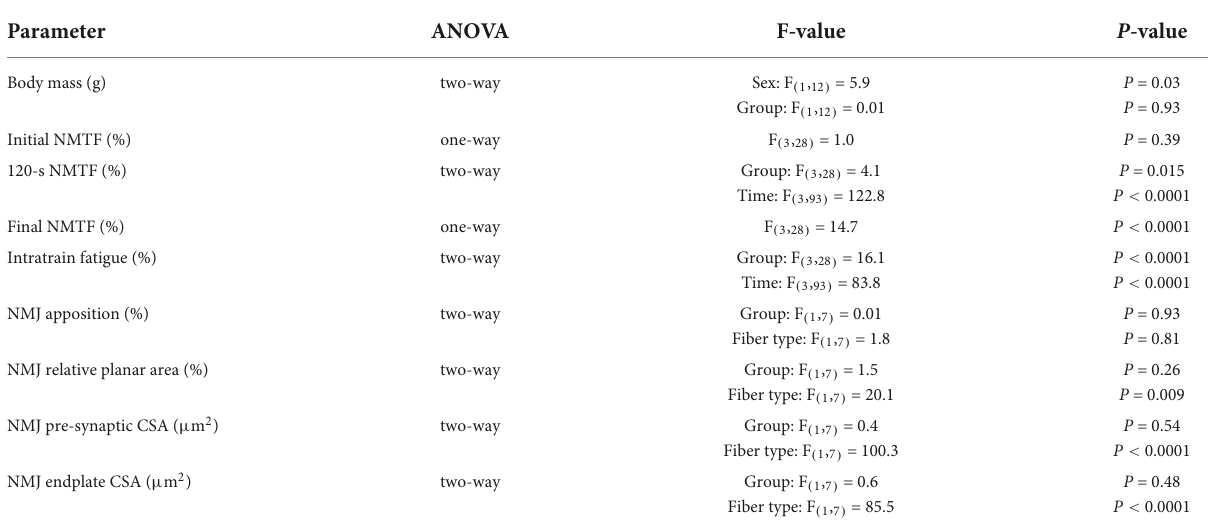
TABLE 1 One- and two-way ANOVA